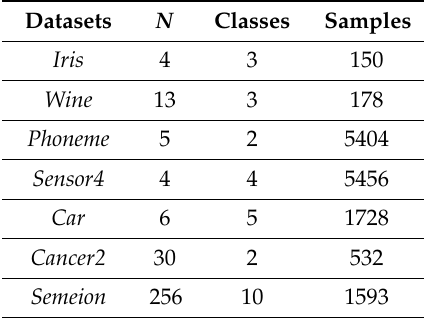
Table 2. The classification problems in N-dimensional (N -D) space.